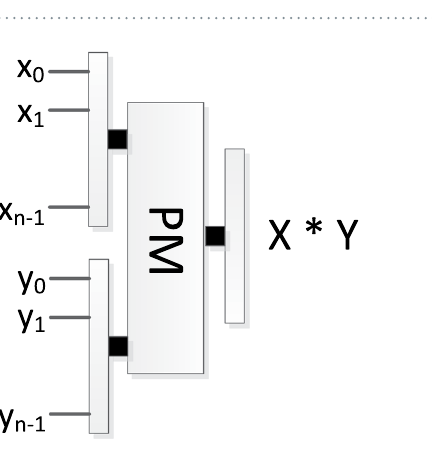
Figure 17. The PS and its block diagram.